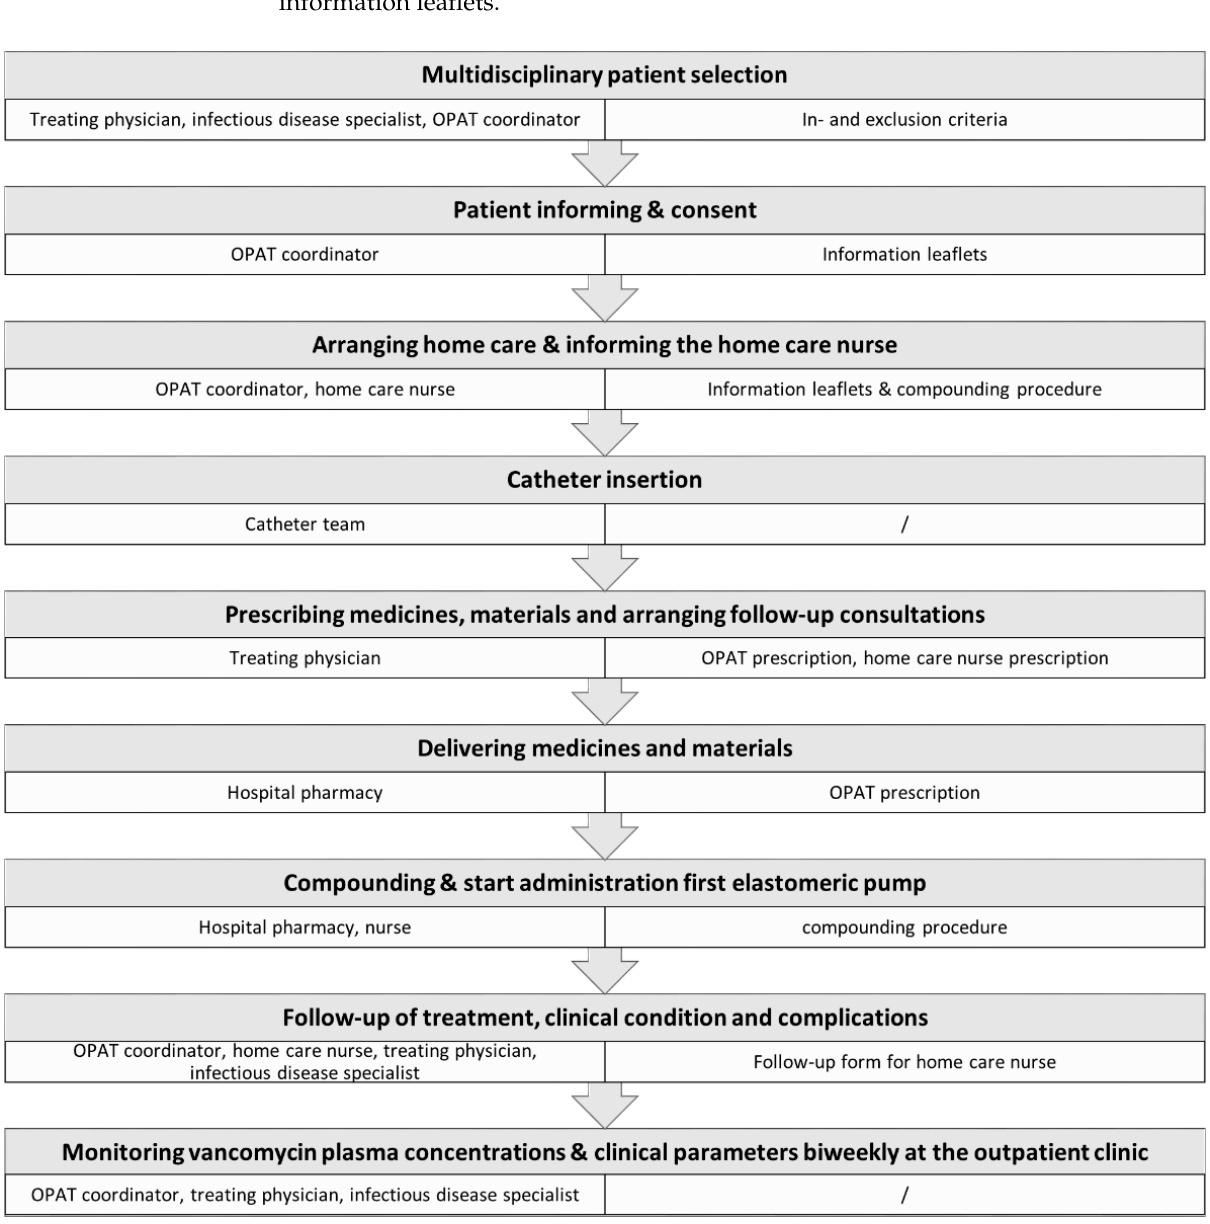
Figure 1. Flow of the structured vOPAT care path of the University Hospitals Leuven. Continuous infusion of vancomycin over 24 h with elastomeric pumps (Baxter, Infusor ® , Deerfield, IL, USA) is the exclusive mode of administration in this OPAT program. There- fore, patients treated with intermittent vancomycin infusion during hospitalization are switched to continuous infusion prior to discharge. Given the high likelihood of